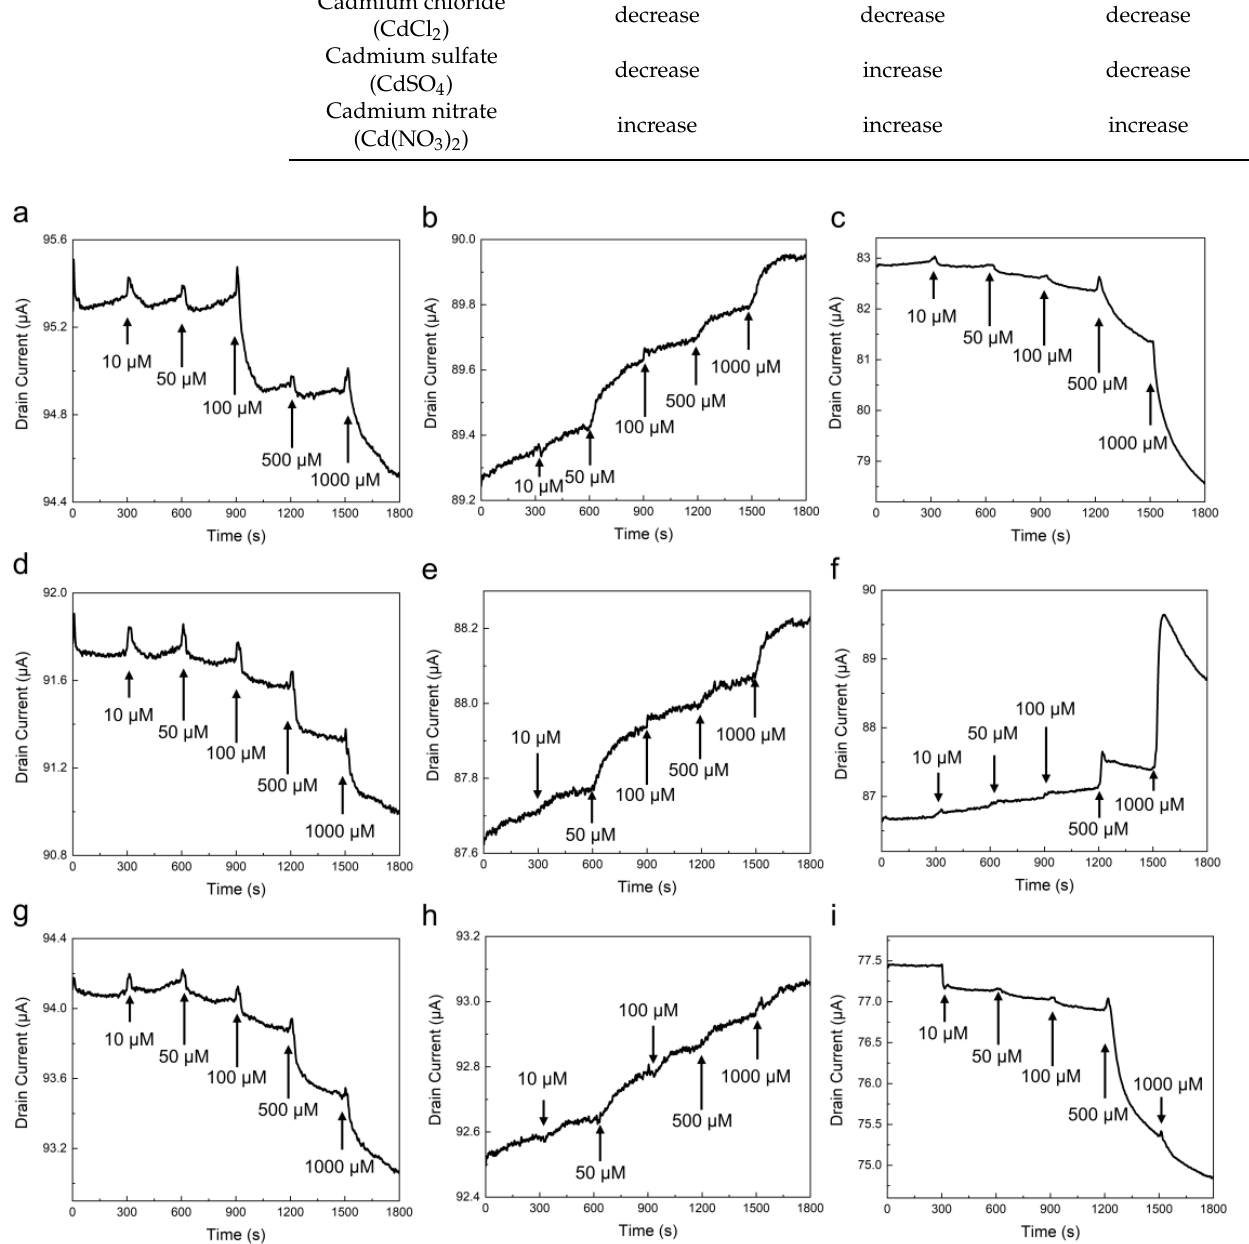
Figure 5. Sensor response of the graphene-based sensors. ( a – c ) Pristine graphene with the introduction of cadmium chloride, cadmium nitrate, and cadmium sulfate, respectively. ( d – f ) TTHA-modified graphene with the introduction of cadmium chloride, cadmium nitrate, and cadmium sulfate, respectively. ( g – i ) Terpyridine-modified graphene with the introduction of cadmium chloride, cadmium nitrate, and cadmium sulfate, respectively.